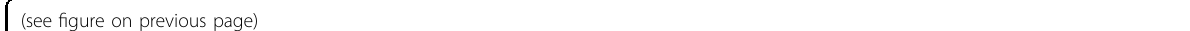
Fig. 5 T cell-autonomous functions of Bach2. Rag2 − / − mice were reconstituted with Tcr β − / − BM cells and either Bach2 KO or WT BM cells to generate T-KO and T-WT chimeric mice. Approximately 10 weeks after BM reconstitution, spleen cells and sera were collected from the recipients and assayed by FACS a – e and g – j and ELISA k , respectively. Spleen cells from approximately 20-week-old Bach2 KO mice and their WT littermates were assayed by FACS f . Representative FACS pro fi les gated on CD4 + a , b and d , CD4 + CXCR5 + c , CD4 + CD62L − e – h , CD4 + CD62L − CD44 hi PSGL1 lo i , and B220 + j are shown. Data are representative of more than three independent experiments and are displayed as the means ± SEMs, with or without symbols representing the values of individual mice. AUs, arbitrary units; Ctl, negative control staining. * p < 0.05, ** p < 0.01 and *** p < 0.001 by Student ’ s t